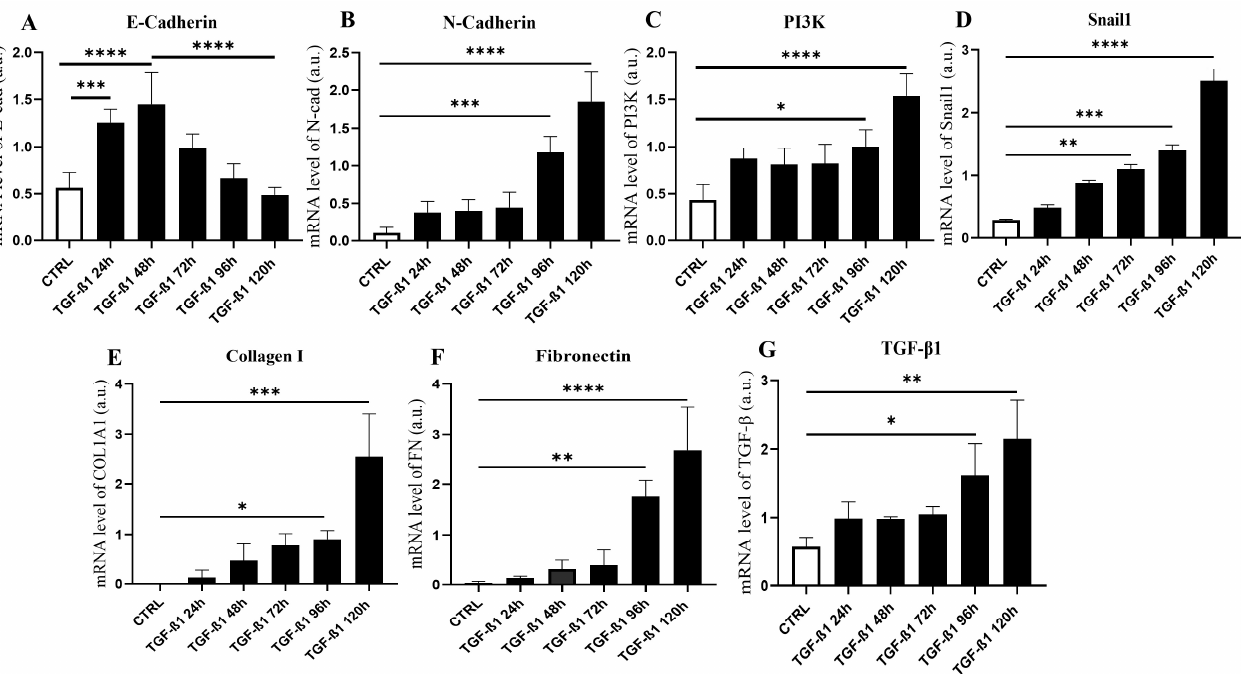
Figure 2. TGF- β 1 triggers modulation of epithelial and mesenchymal marker expression. The mRNA levels of E-cadherin ( A ), N-cadherin ( B ), PI3K ( C ), Snai1 ( D ), Collagen ( E ), Fibronectin ( F ), and TGF- β ( G ) in the control and TGF- β 1-treated MCF-10A cells at different time points. Following TGF- β 1 treatment, noncancerous breast cells progressively lose the epithelial features, acquiring mesenchymal hallmarks, such as De Novo expression of N-cadherin, increased synthesis of Snai1, and reduced expression of E-cadherin. Noting that once the transformation process has reached a steady stae (i.e., 120 h), the system requires a very relevant increase in PI3K activity. Moreover, EMT is accompanied by a signi fi cant change in collagen and fi bronectin release that can, in turn, modify